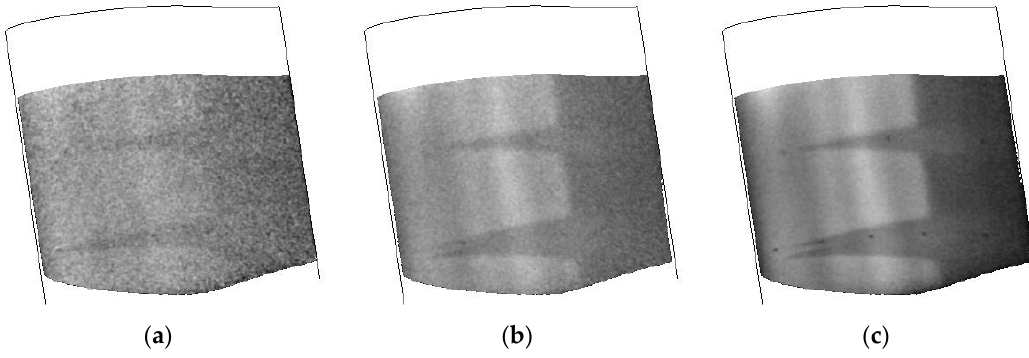
Figure 8. Applying increasing current to the CNT layer: ( a ) 50 V; ( b ) 100 V; and ( c ) 150 V.